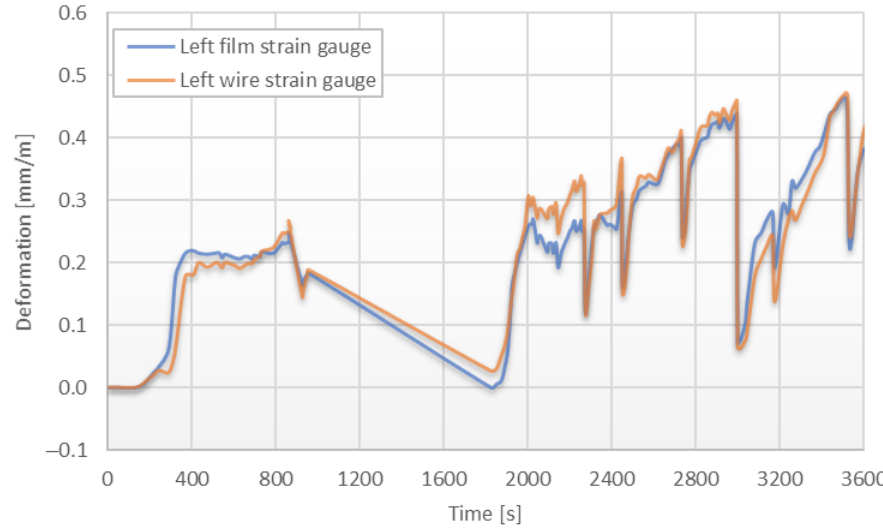
Figure 16. Results of deformation (left side).